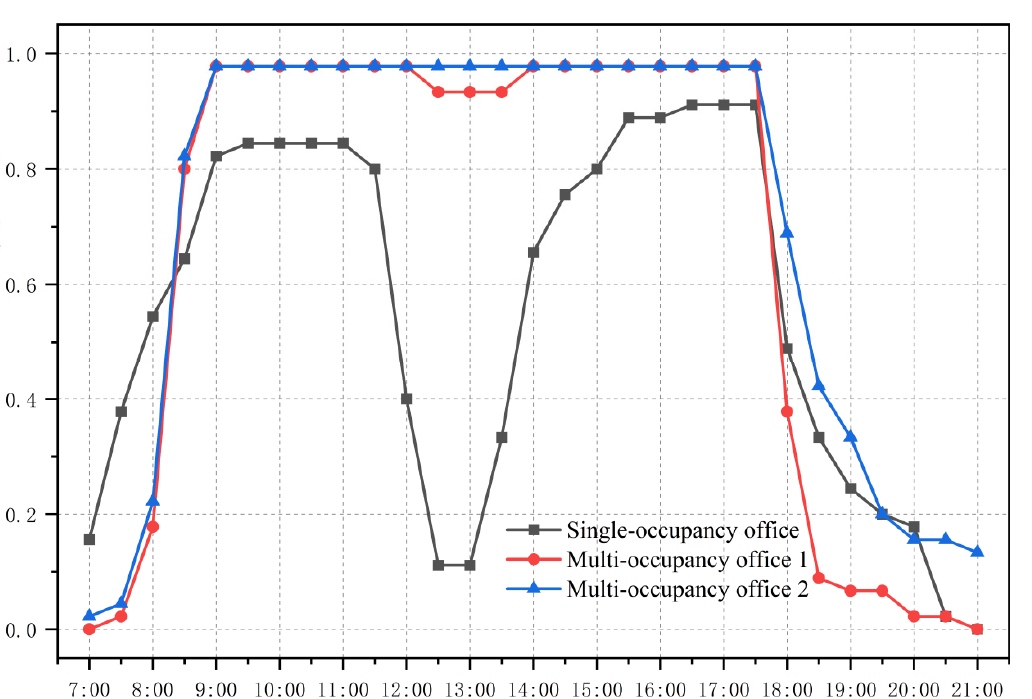
Figure 11. Turn on the luminaire probability in